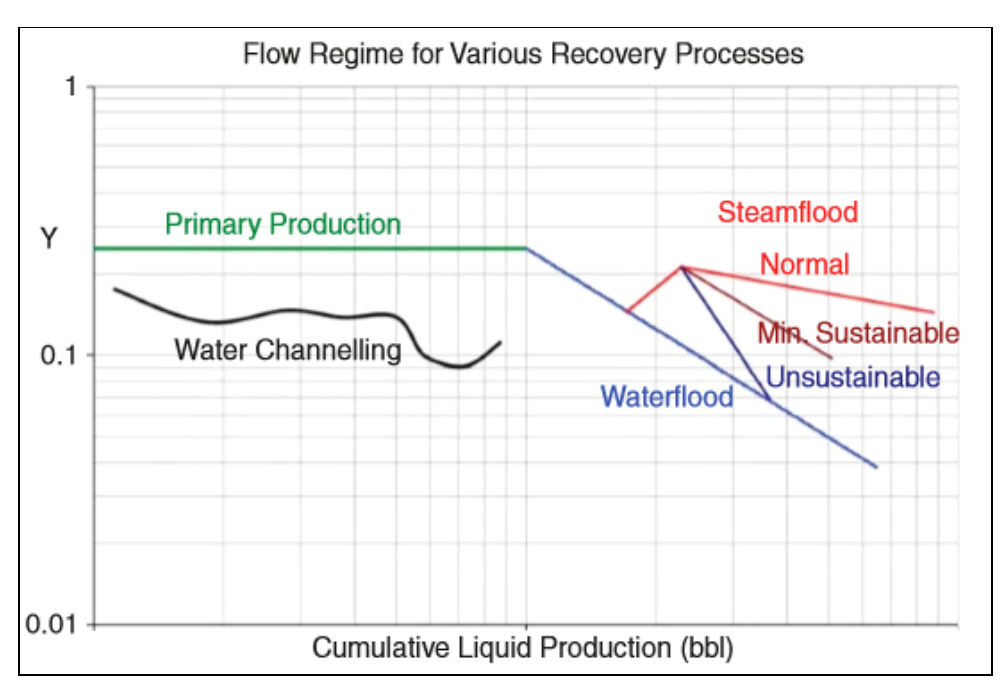
Figure 20. Flow-regime diagram for production surveillance